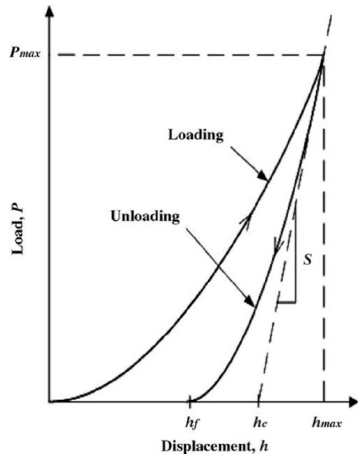
Figure 3. Schematic diagram of the indentation load-displacement curve showing important measured parameters such as peak load, P max , maximum penetration depth, h max , final depth after removing the load, h f , contact depth, h c , and the unloading stiffness, S. (Reproduced with permission from Materials Research Society, Reference